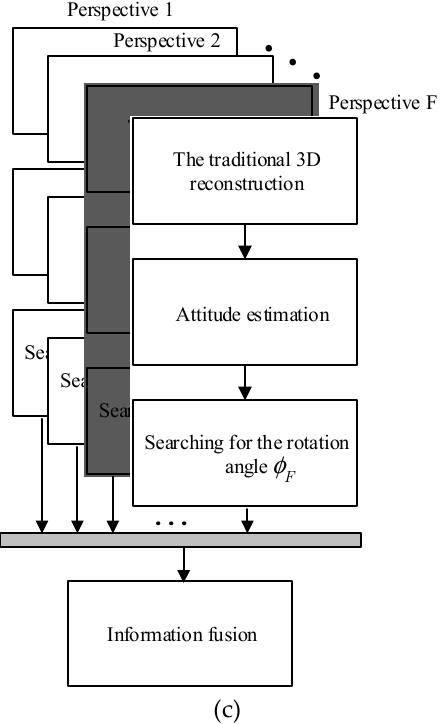
Figure 5. Algorithm of multi-perspective 3D reconstruction summary. (a) The traditional 3D Figure 5. Algorithmofmulti-perspective3Dreconstructionsummary. ( a )Thetraditional3Dreconstruction. reconstruction. (b) The procedure of attitude estimation for the fth perspective . (c) Multi-perspective ( b ) The procedure of attitude estimation for the f th perspective. ( c ) Multi-perspective 3D imaging. 3D imaging.